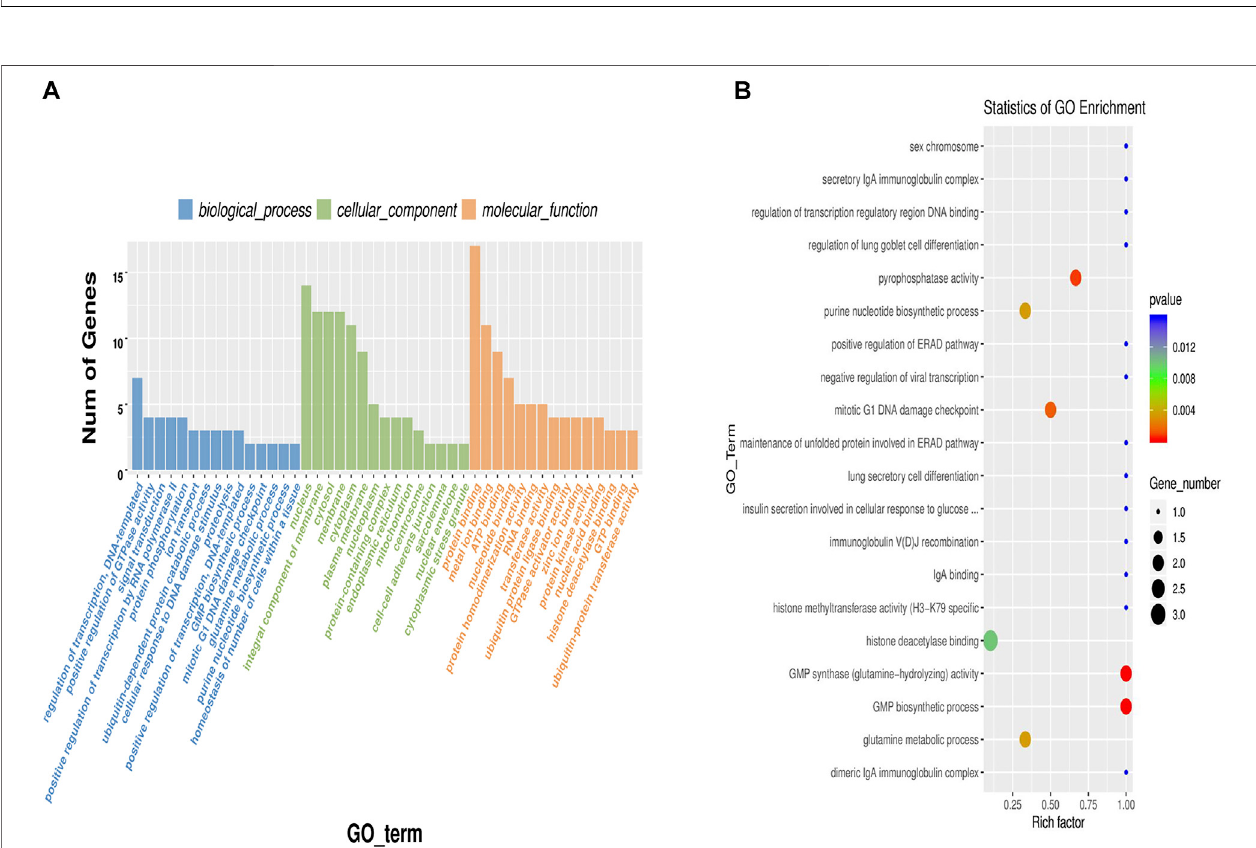
FIGURE 4 | Gene Ontology (GO) enrichment analysis of differentially expressed circular RNA (circRNA)-hosting genes. (A) A histogram of differentially expressed circRNA-hosting genes enrichment analysis; (B) A scatter plot of differentially expressed circRNA-hosting genes enrichment analysis. The dot size represents the number of genes with a signi fi cant difference that matches the S gene number of a single GO term, and the color of the dot represents the p -value of the enrichment analysis (i.e., enrichment signi fi cance).